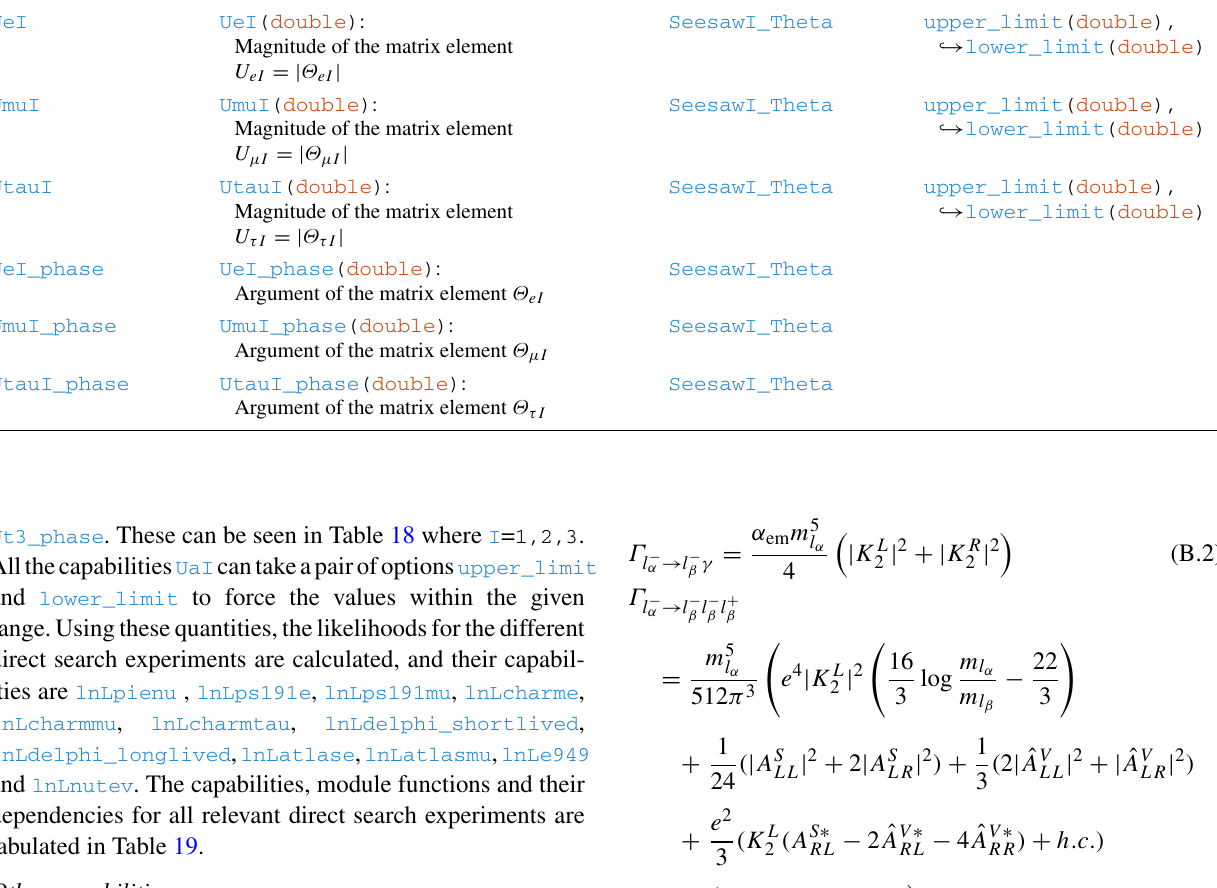
Table 18 Capabilities and module functions that calculate the magnitude and argument of the matrix elements of Θ ( I = 1,2,3 )